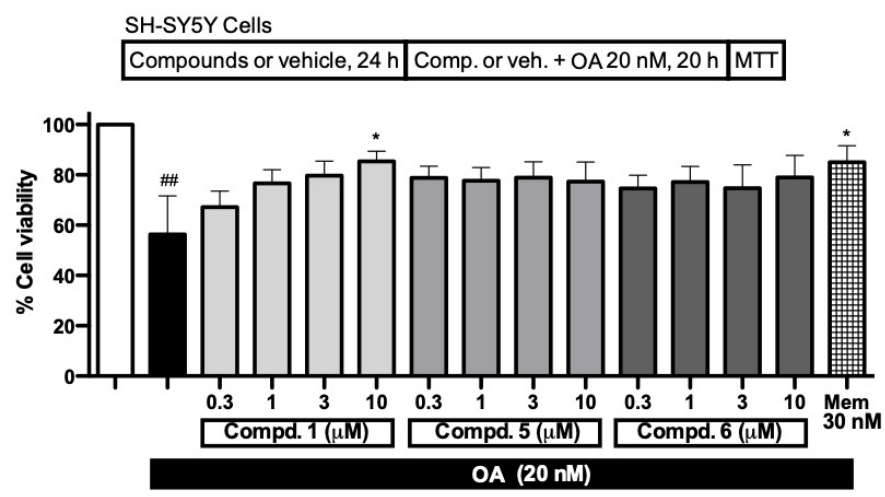
Figure 5. Cell viability (in %) of SH-SY5Y neuroblastoma cells challenged with okadaic acid (OA), and neuroprotective effect of compounds 1, 5 and 6 (0.3–10 µM). Cell viability of cells subjected to OA (20 nM) for 20 h was measured using MTT assay, and compared with cell viability of vehicle treated cells (white bar). Data are mean ± SEM of four independent experiments. ## p < 0.01, with respect to untreated cells (white bar); * p < 0.05, with respect to SH-SY5Y cells only treated with OA (black bar).